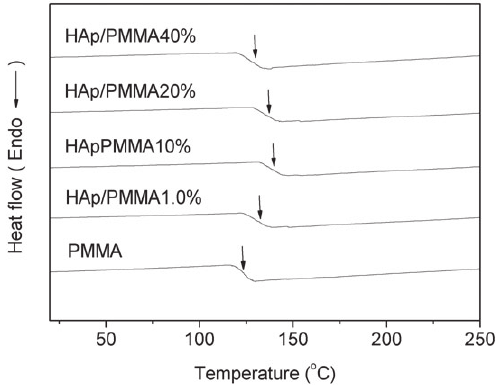
Figure 6 DSC thermograms of HAp/PMMA nanocomposites and